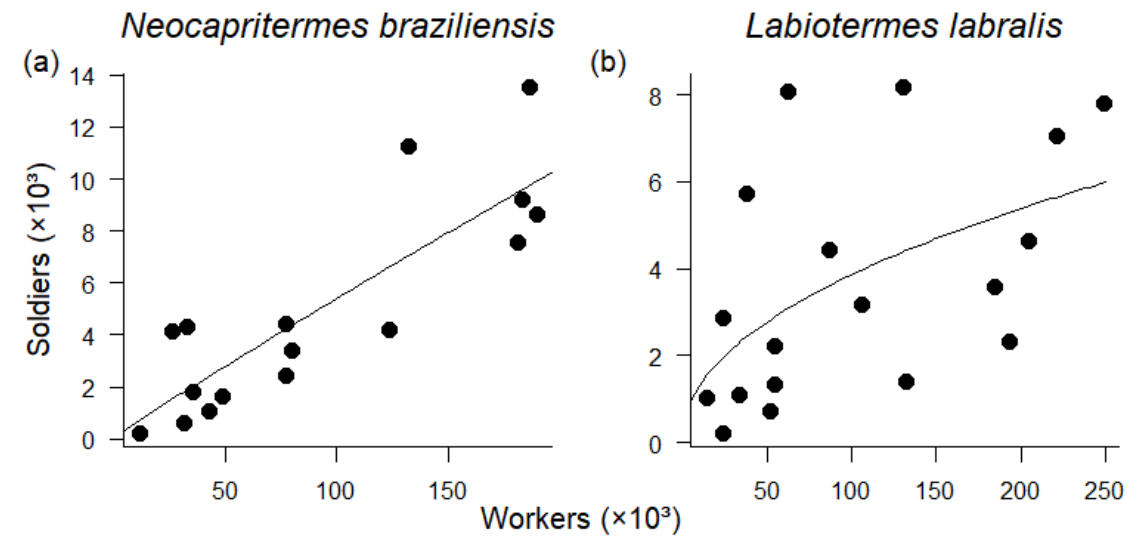
Fig 4 . Whole-colony scalings of defense in two Amazonian termite species. Points represent colonies. Solid lines represent statistically significant GLM fits at the 0.05 level, as indicated in Table